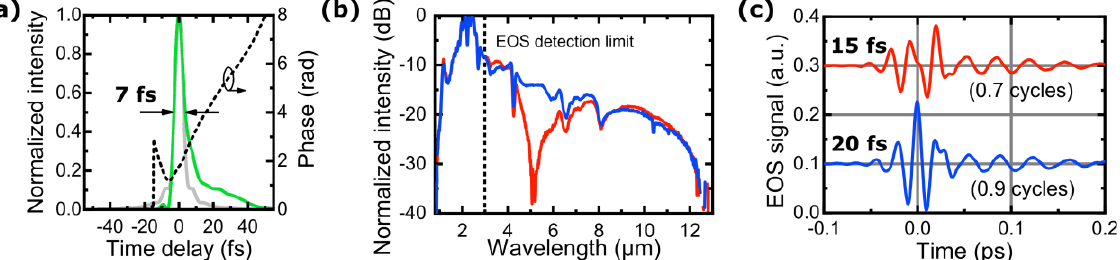
Fig. 1 (a) Single-cycle driving pulse as retrieved from SHG-FROG (green) compared with the Fourier-limited pulse (grey). (b) Supercontinuum from cascaded IPDFG for the extreme cases of CEP-dependent constructive (blue) and destructive (red) interference between the even and odd cascaded IPDFG orders. EOS measurement with 7-fs gating pulse allows to measure components with wavelengths longer than ~3μm. (c) EOS traces of the supercontinuum pulses in b ; the FWHM pulse durations and the number of optical cycles at the spectral centroid are indicated. The frontend of our setup is a diode-pumped Kerr-lens mode-locked Cr:ZnS laser oscillator producing 28 fs pulses at 2.3 μm. The repetition rate and the average output power amounted to 23 MHz and 480 mW, respectively. The laser output was focused into a 0.5-mm-thick TiO 2 plate, providing spectral broadening to a super-octave- spanning bandwidth (1.1 – 3.2 μm), with a corresponding Fourier-limit of 6 fs. The pulses were compressed with custom-designed multilayer dispersive mirrors down to 7 fs (Fig. 1a), constituting the first demonstration of single- cycle pulses generated with chromium-doped II-VI laser technology. These single-cycle pulses were CEP- stabilized with a residual phase noise of only 11 mrad (integrated from 1 mHz to 11.5 MHz). Subsequently, the beam was focused into a ZGP nonlinear crystal for cascaded IPDFG, resulting in an infrared supercontinnum covering 3.7 optical octaves (0.9 – 12 μm; Fig. 1b). The output power of the mid-IR (λ > 3.6 μm) amounted